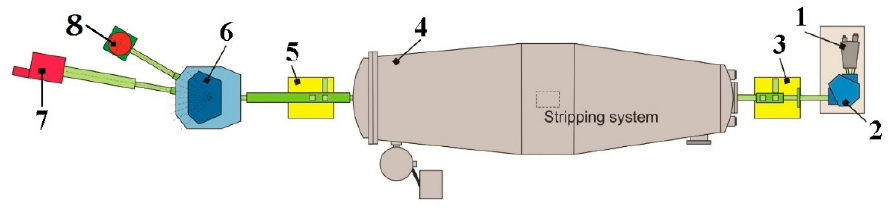
Figure 1. Layout of the 6 MV tandem accelerator: (1) Ion sources; (2) Mass analyzing magnet; (3) Focusing system in front of the accelerator; (4) Tandem accelerator tank; (5) Quadrupole triplet lens; (6) Switching magnet; (7) Modification chamber; (8) Ion beam analysis end-station.